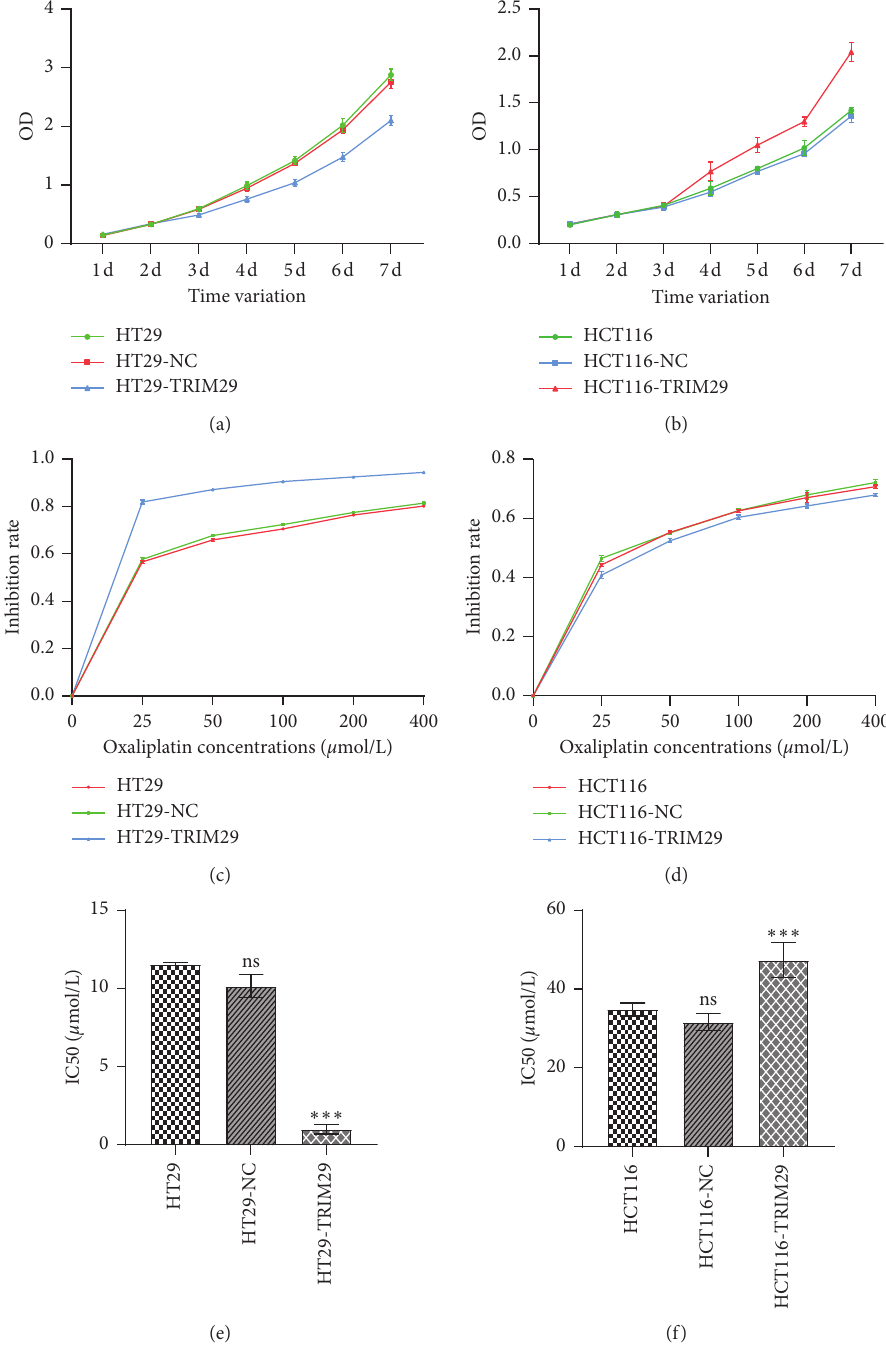
Figure 2: TRIM29 significantly increased the sensitivity of P53 mutant colon cancer cell HT29 to oxaliplatin. (a) HT29 cell growth curve after transfection of pIRES2-ZsGreen1-TRIM29-flag plasmid. (b) HCT116 cell growth curve after transfection of pIRES2-ZsGreen1- TRIM29-flag plasmid. (c) HT29 cell inhibition curve to oxaliplatin after transfection of pIRES2-ZsGreen1-TRIM29-flag plasmid. (d) HCT116 cell inhibition curve to oxaliplatin after transfection of pIRES2-ZsGreen1-TRIM29-flag plasmid. (e) IC50 change of HT29 cells after transfection of pIRES2-ZsGreen1-TRIM29-flag plasmid. (f) IC50 change of HCT116 cells after transfection of